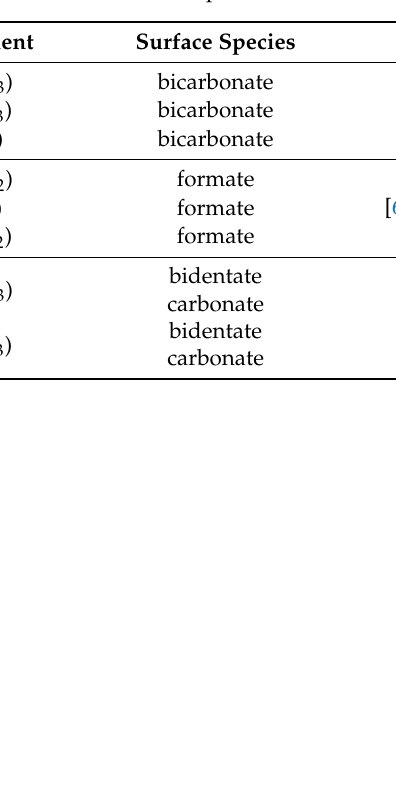
Table 2. Surface species and their assignments to TPSR-DRIFTS spectra.